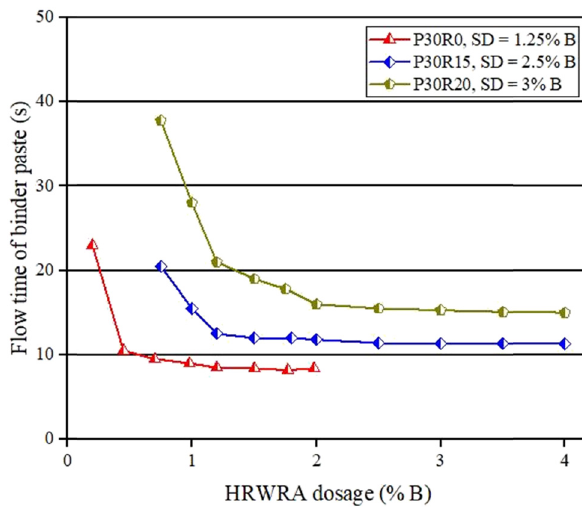
Figure 1: Flow time of various binder pastes [ 45 ] .